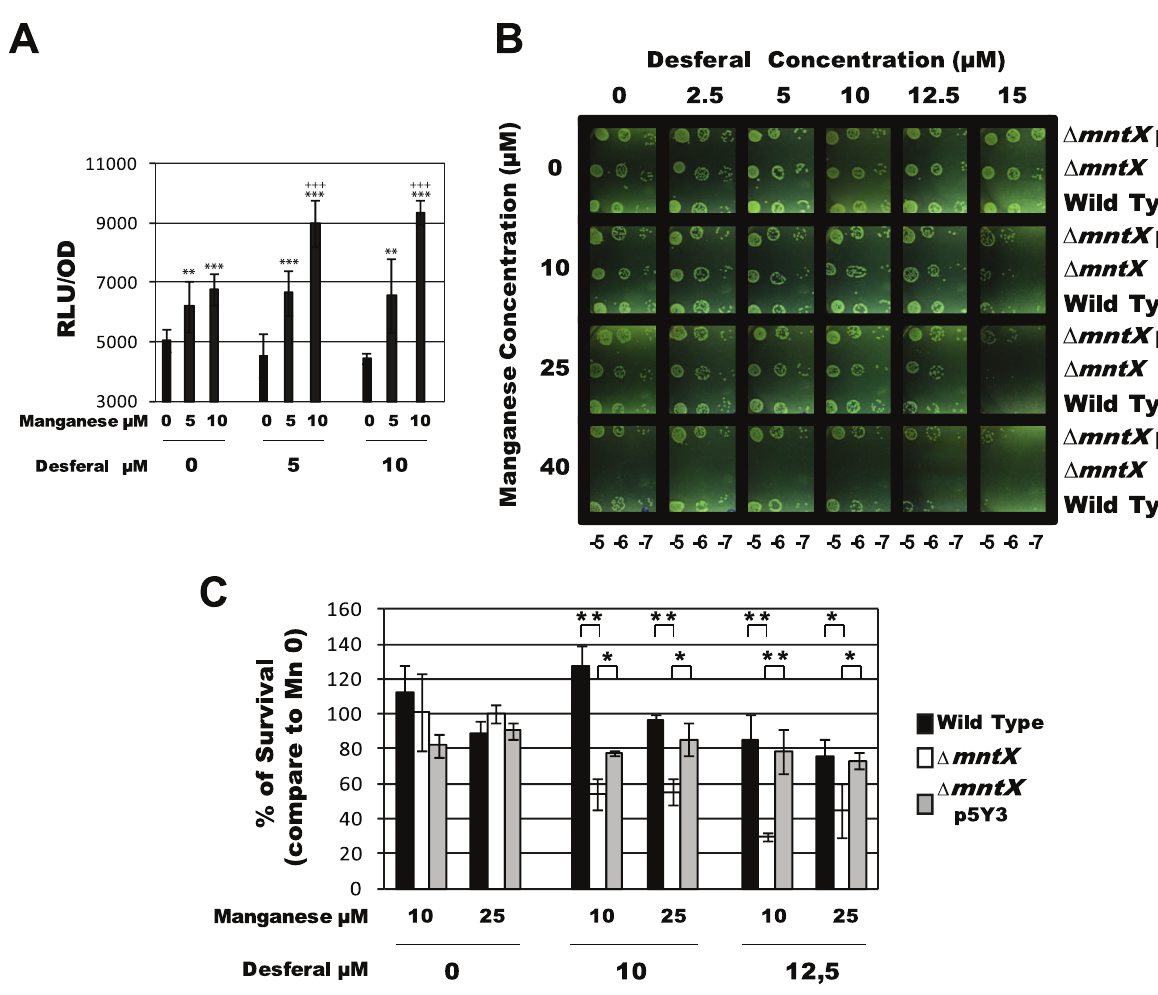
Figure 6. MntX protects N.meningitidis from Mn cytotoxicity exacerbated in low iron condition. A ) Light emission normalized with OD, and done in triplicates, of N. meningitidis harboring P mntX :: luc and grown in GCB agar for 4 hours containing indicated concentration of Desferal and manganese. (*** p , 0.01, ** p , 0.05 in comparison to the same Desferal concentration without Mn; +++ p , 0.01 in comparison to the same Mn concentration without Desferal). B ) Serial dilution plate assays were performed to compare the tolerance to iron chelation (Desferal) of N. meningitidis wild type strain, D mntX mutant and the complemented strain, in the presence of increased concentrations of MnCl 2 . C ) Percentage of CFU growing on Desferal and manganese compared to those growing in the same concentration of Desferal but without manganese. Each bar represents the mean of three measurements. (*** p , 0.01, ** p , 0.05)